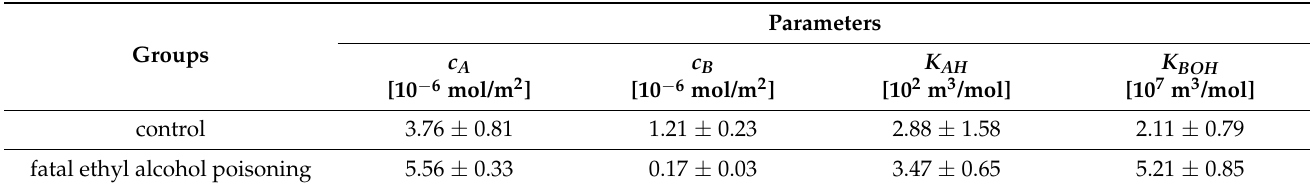
Table 4. The total acid and base concentrations of the functional groups of thrombocytes and their association constants with H + and OH −